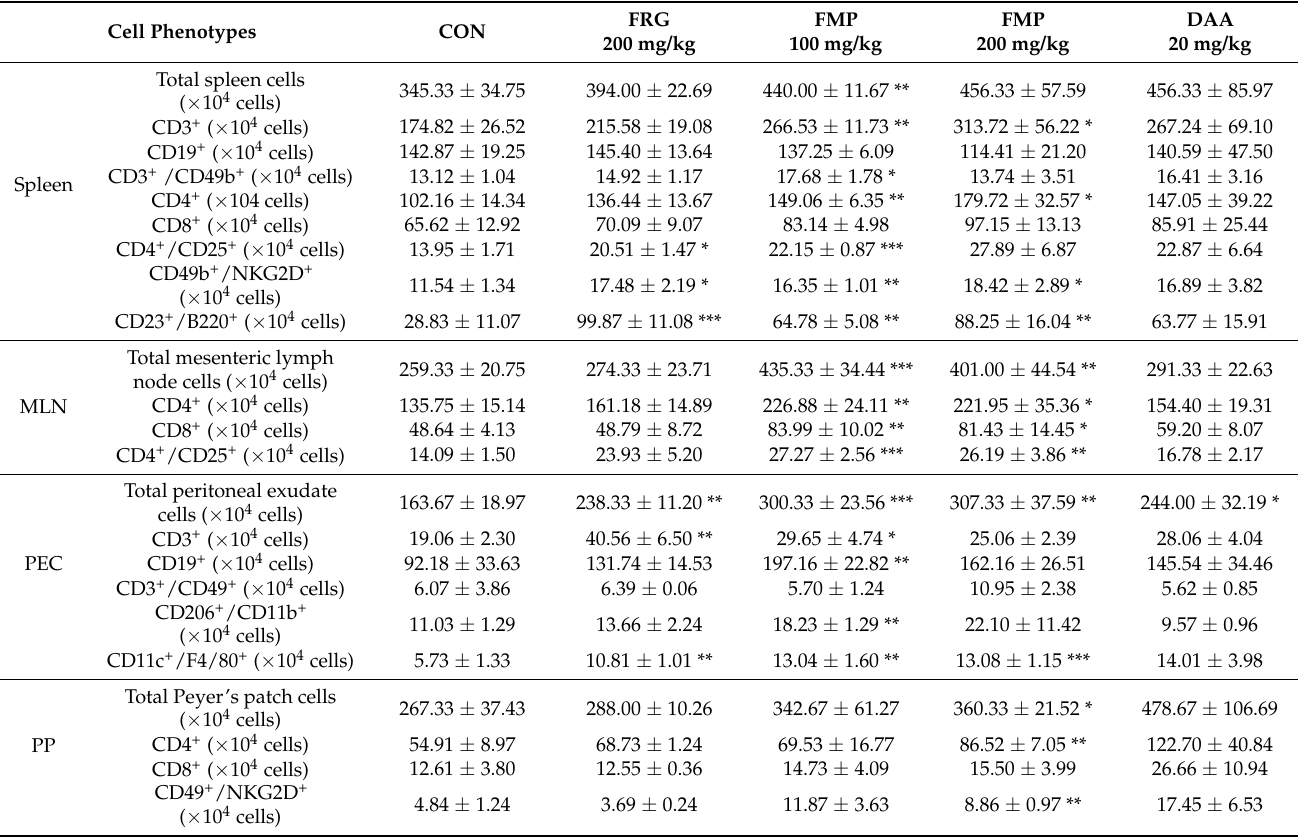
Table 1. Effects of FMP on the spleen, mesenteric lymph node, peritoneal exudate, and Peyer’s patch immune absolute cell number in Balb/c